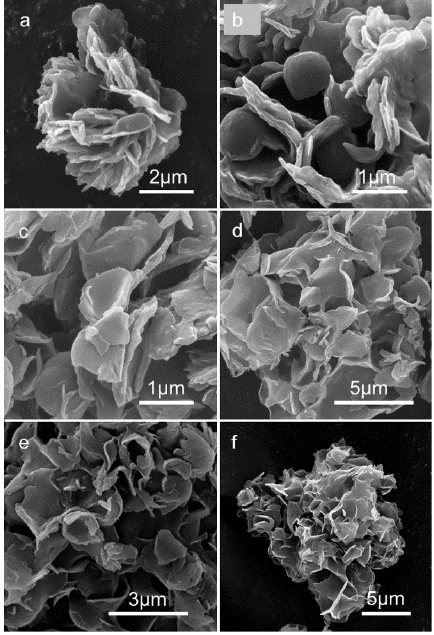
Figure 3. SEM images of the polymerization products of C 18 H 37 SiH 3 by 0.01 g ZIF-8 at 90 °C ( a ) 5 min; ( b ) 1 h; ( c ) 2 h; ( d ) 4 h; ( e ) 6 h; ( f ) 12 h.